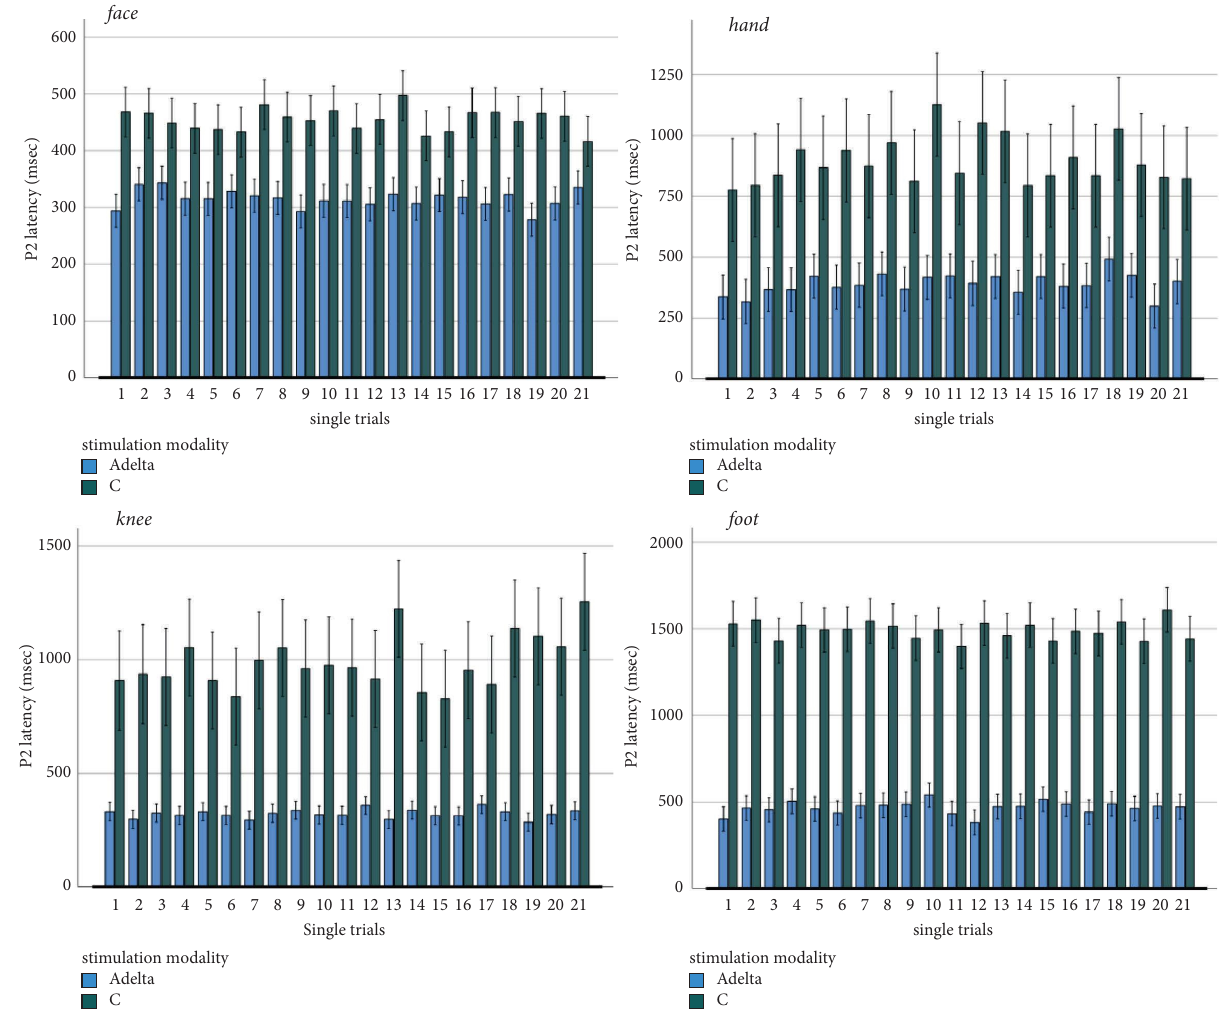
Figure 2: Mean values and standard errors of latencies of major amplitude positive peaks measurable in single trials in 20 healthy subjects with a-delta and C-modality of